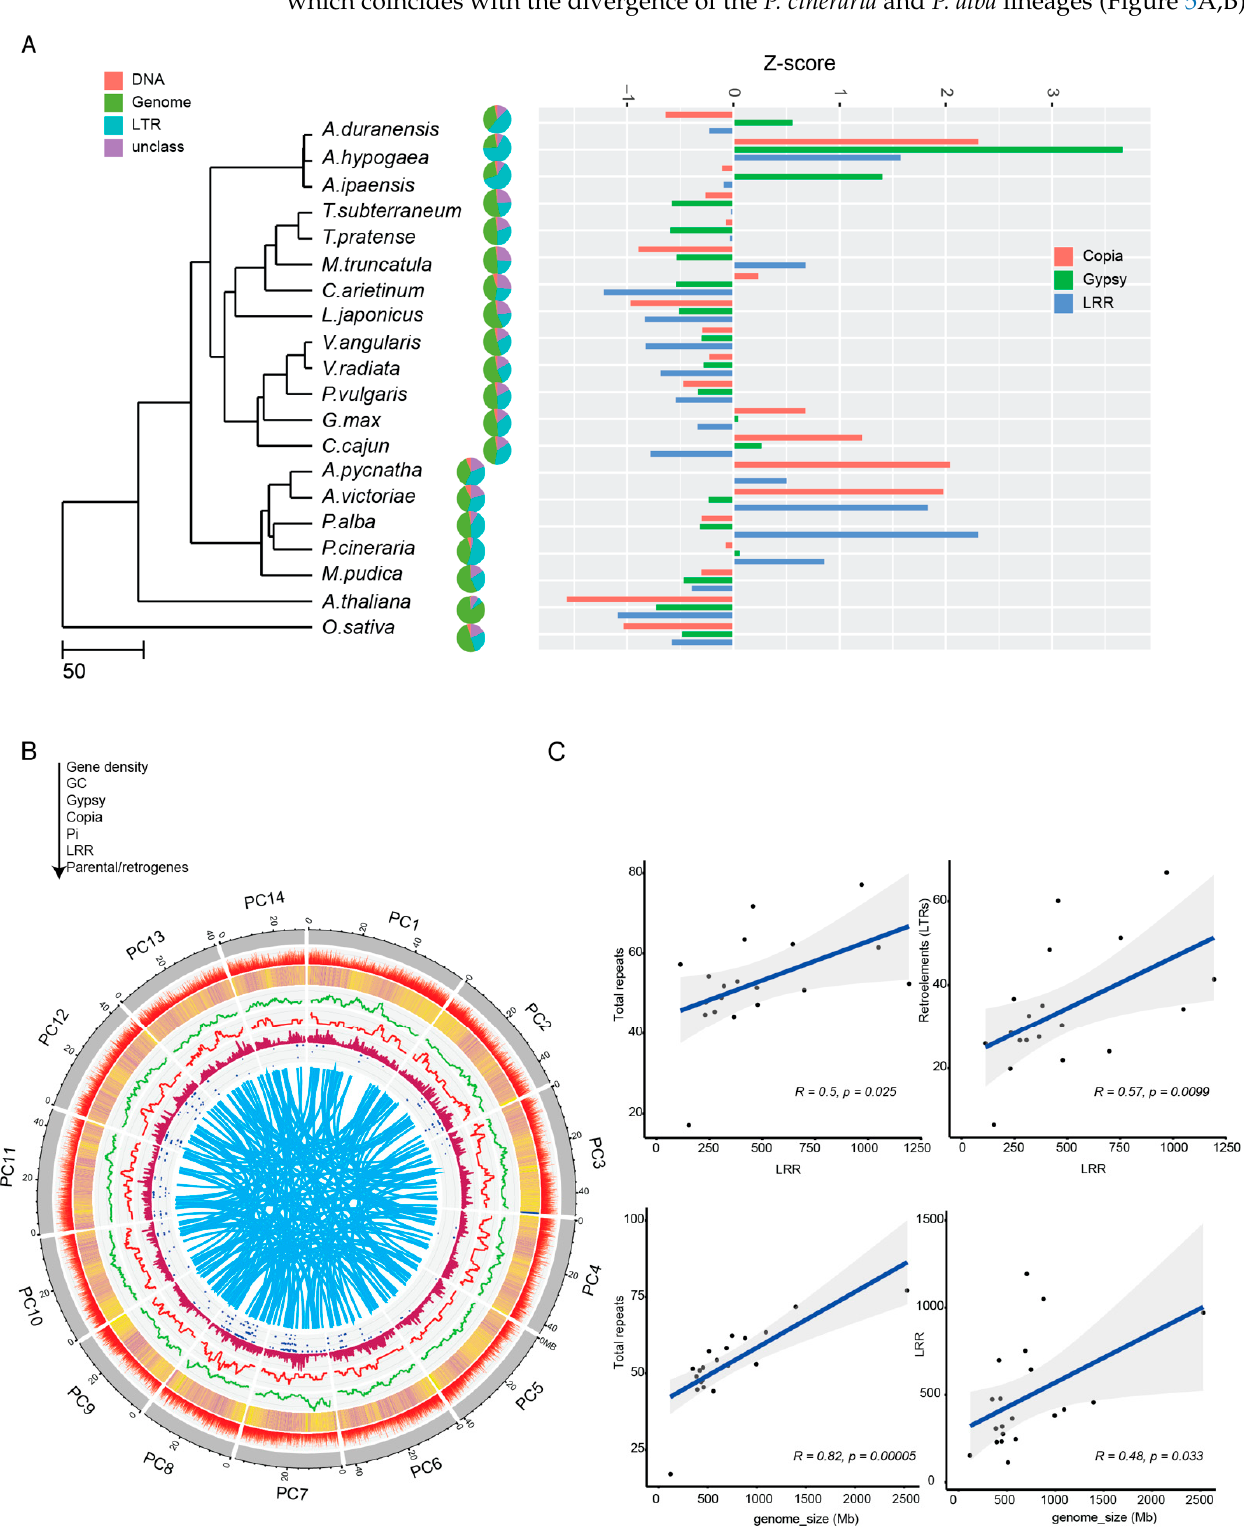
Figure 3. Comparative genome analysis of repeats, including disease resistance genes (NBS ‐ LRR). ( A ) Pie chart of the percentage of DNA, LTR ‐ retrotranspons, and unclassified repeats of the genome mapped onto the ultrameric tree. Z ‐ score of the number of NBS ‐ LRR, copia ‐ like and gypsy ‐ like LTR ‐ retrotransposons across the phylogenetic tree. Positive values show increase in number while neg ‐ ative values depict a decrease. ( B ) Circos plot of co ‐ localization of repeats and disease ‐ resistance